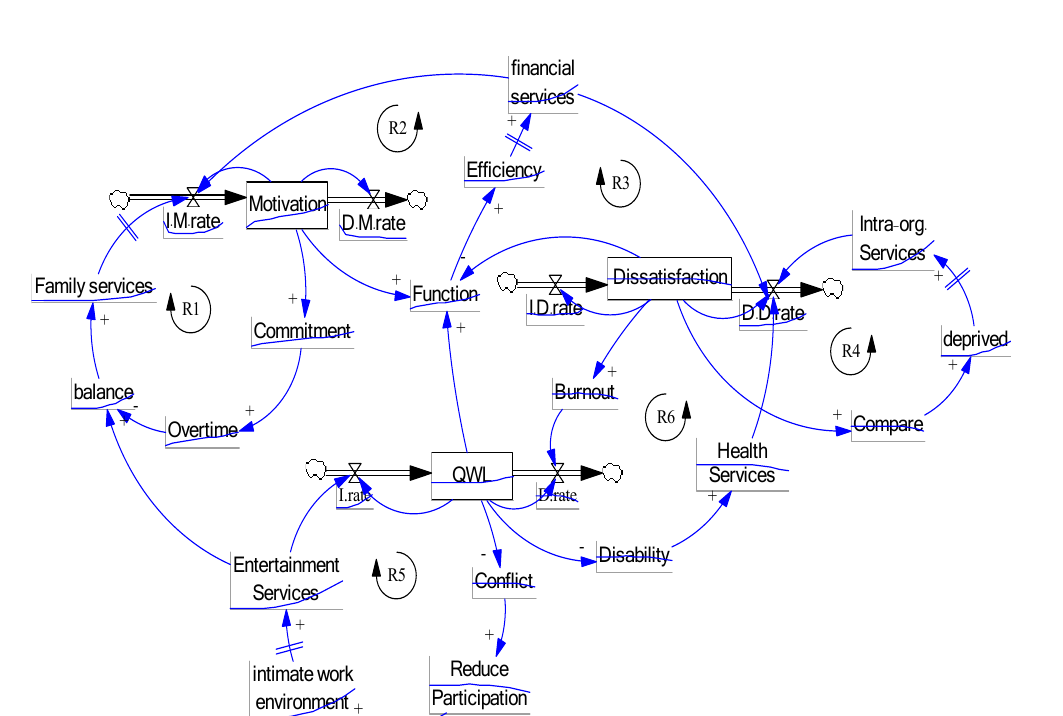
Fig. 3. The dynamics of systems in the existing situation after running in the Fig. 3: The dynamics of systems in the existing situation after running in the software